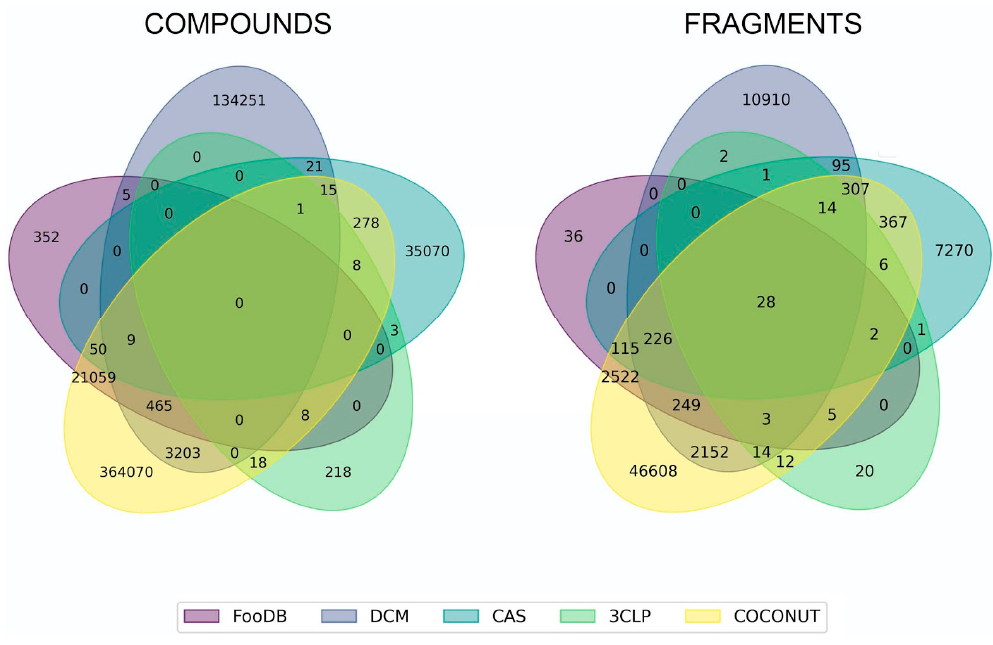
Figure 1. Unique and overlapping compounds and fragments from COCONUT, FooDB, DCM, CAS, and 3CLP. Compounds and fragments are represented with colors: yellow (COCONUT), violet (FooDB), purple (DCM), green (CAS), and lime (3CLP).